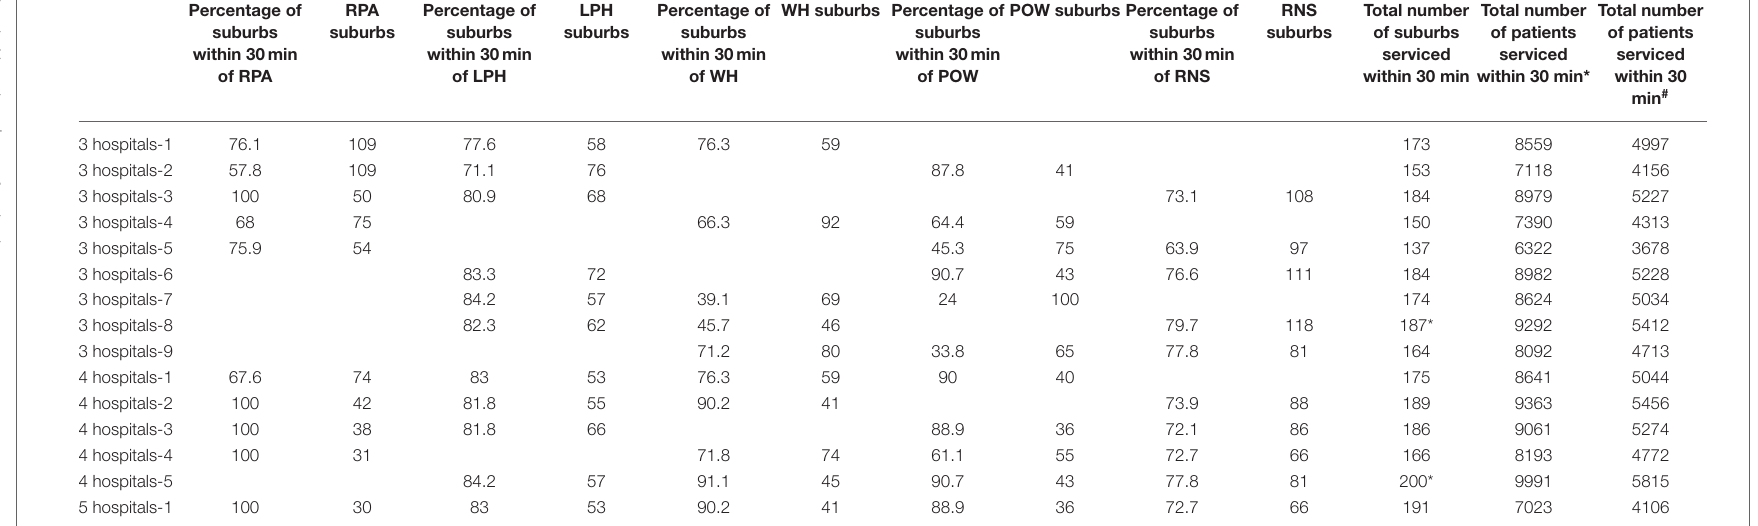
TABLE 1 | Traveling time and coverage area for different combinations of ECR hub models in metropolitan Sydney.